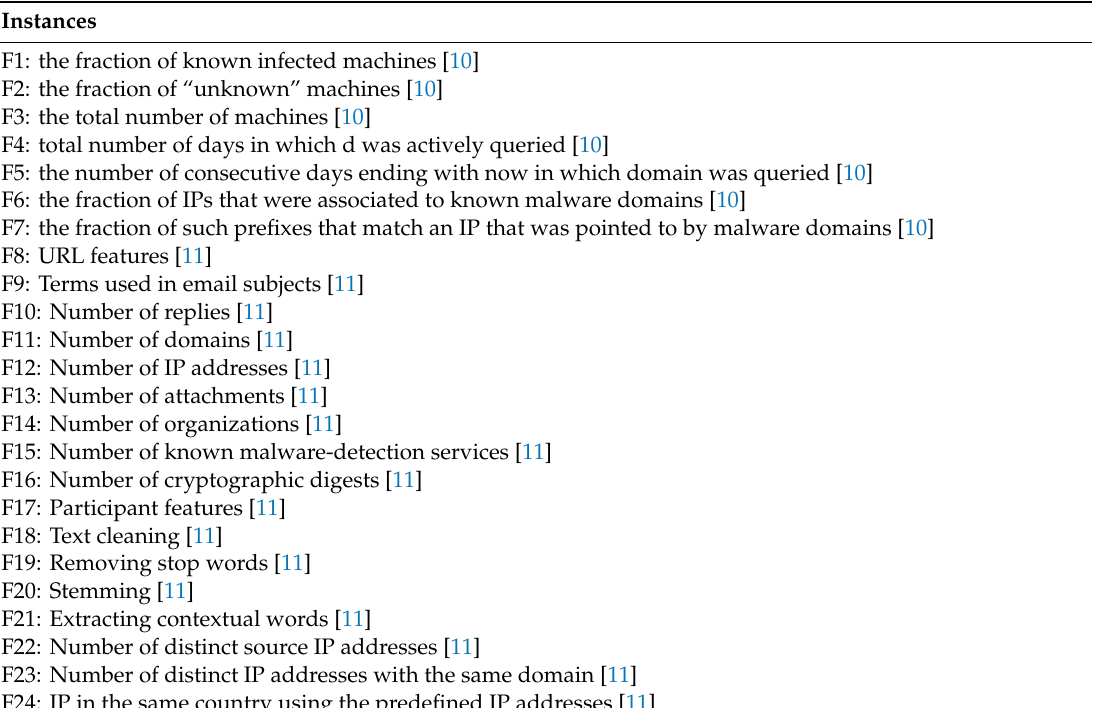
Table 1. Feature